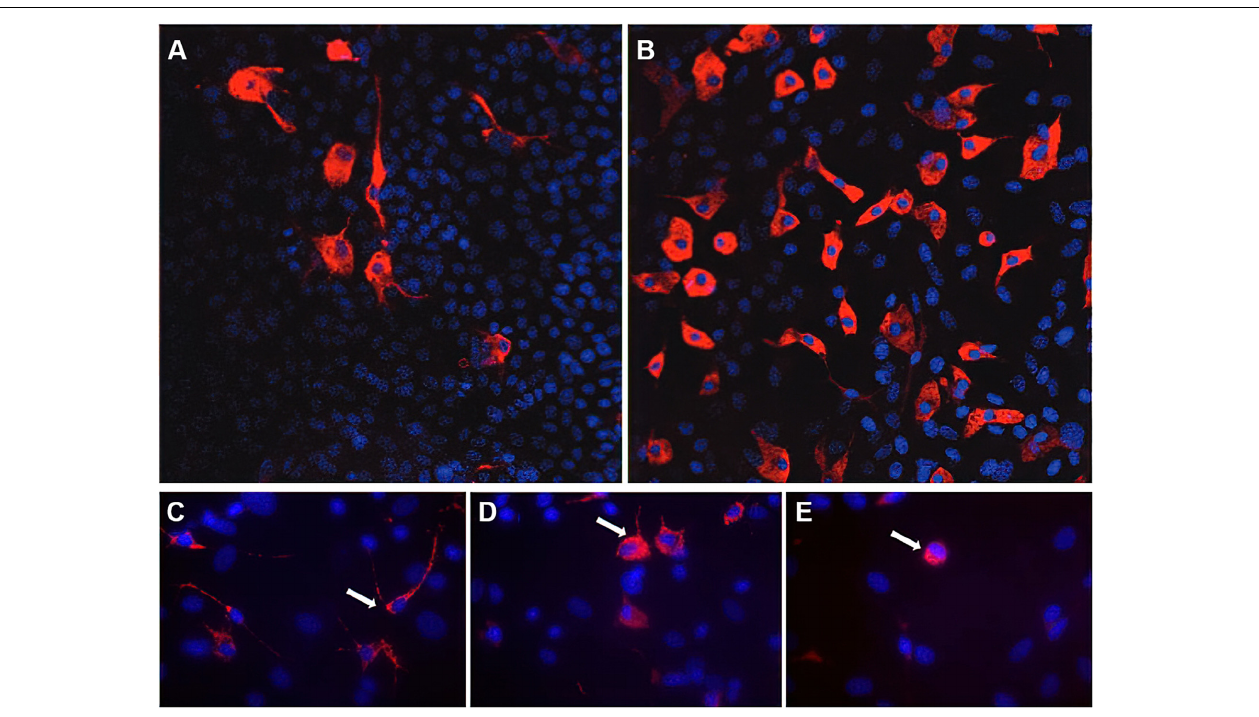
FIGURE 1 | Immunocytochemistry of microglia morphology in M5 und M30 astrocyte-microglia co-cultures. Physiological M5 co-cultures containing 5% microglia (red) (A) . Pathological, inflammatory M30 co-cultures containing 30% microglia (B) (published by Dambach et al., 2014). Staining with the monoclonal antibody ED-1 allowed the classification of microglia (white arrows) as resting ramified (C) , intermediate (D) and activated rounded phagocytic (E) phenotype (published by Ismail et al., 2021). Nuclei (blue) were counterstained with DAPI to visualize the total glial cell